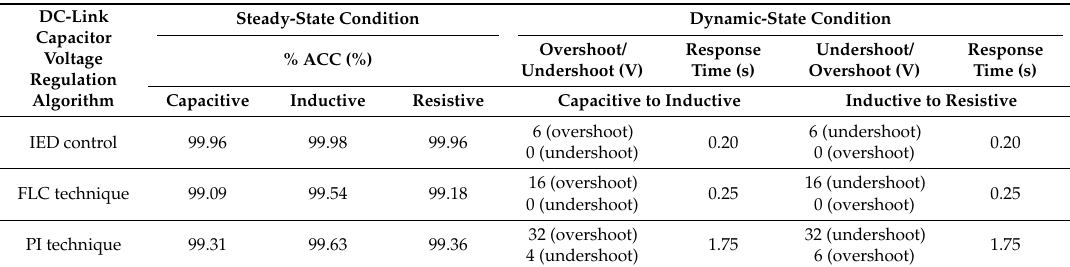
Table 8. Voltage regulation performance of each DC-link capacitor voltage regulation algorithm (experimental